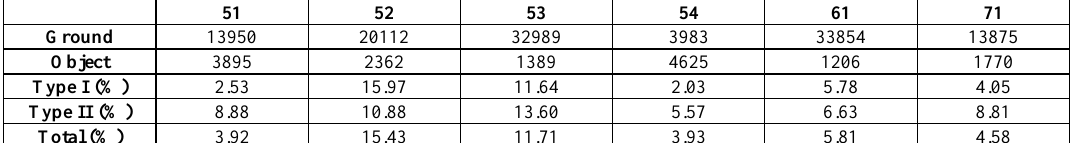
Table 3. Filtering result of sample 51-71